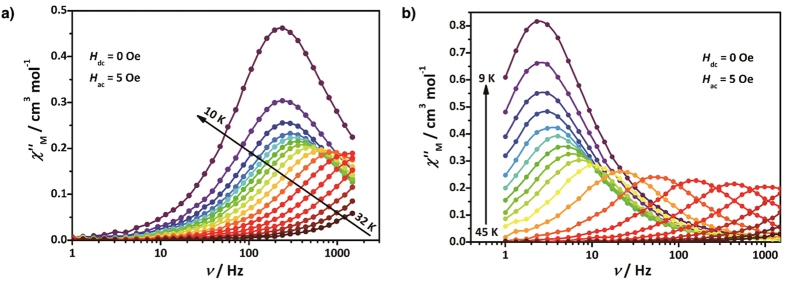
Out-of-phase ac magnetic susceptibilities (χM”) for [CoII2DyIII].(a) Out-of-phase susceptibility for 1∙3H2O in Hdc = 0 Oe and Hac = 5 Oe. (b) Out-of-phase susceptibility for 1 in Hdc = 0 Oe and Hac = 5 Oe. All solid lines are visual guides.